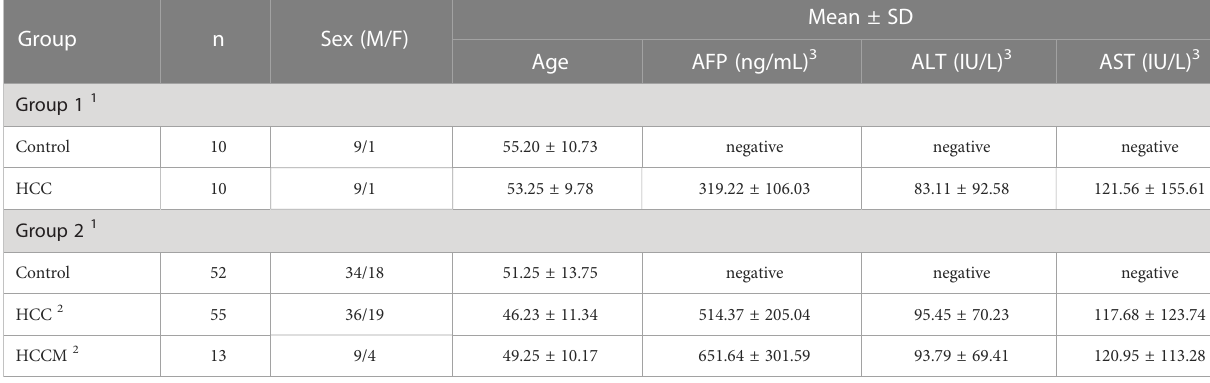
TABLE 2 Detailed summary of serum samples.